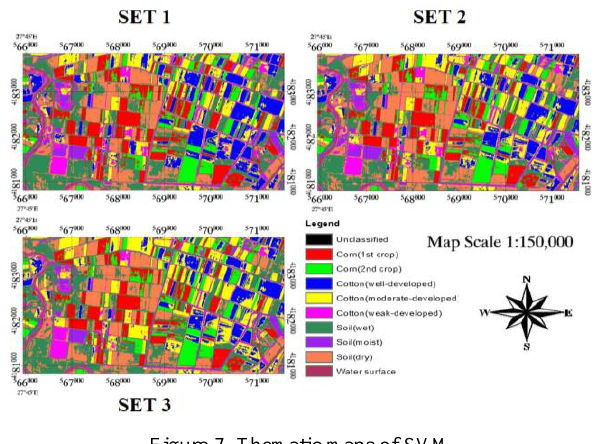
Figure 7. Thematic maps of SVM